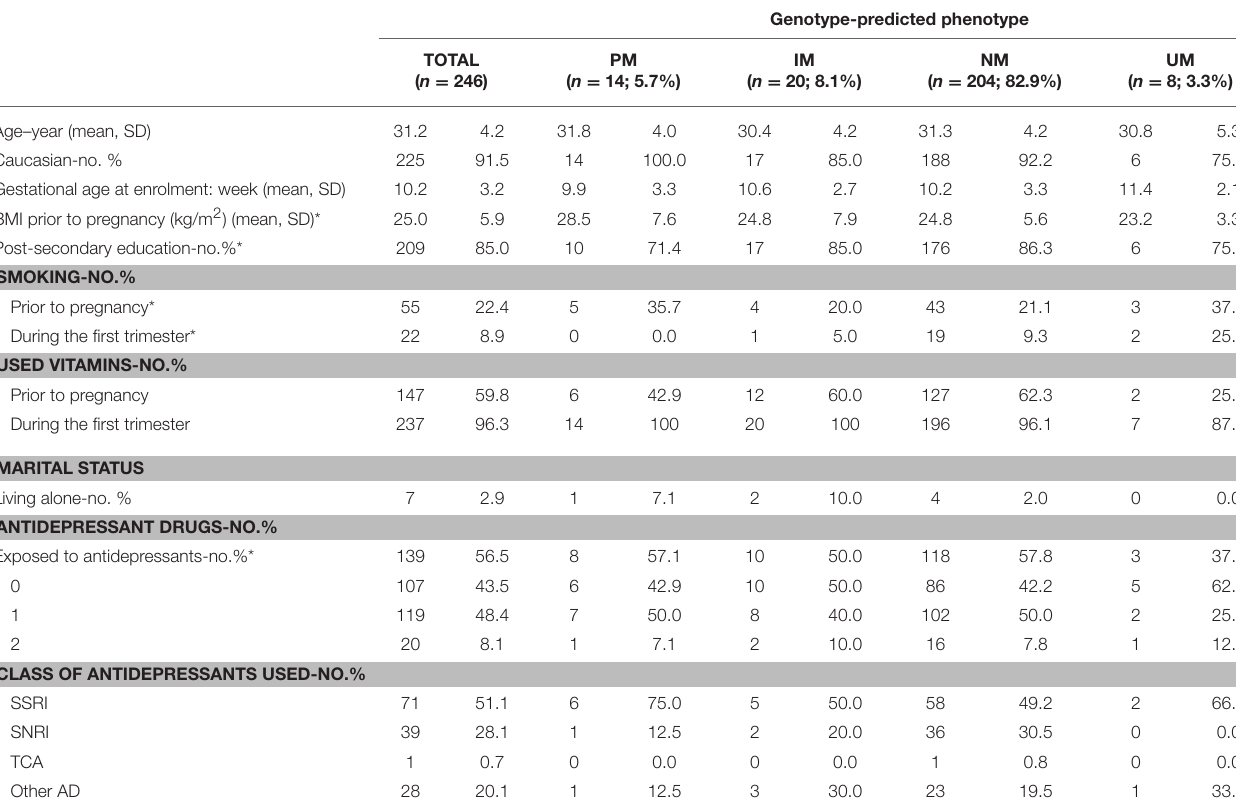
TABLE 1 | Characteristics of participants at enrollment (1st trimester of pregnancy), according to CYP2D6 predicted phenotypes.